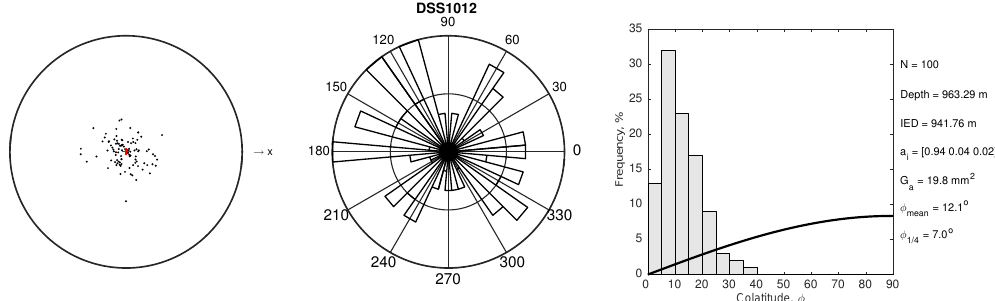
Figure 5. Sample of the thin-section figures included with the data set. From left to right: (i) lower hemisphere c -axis Schmidt plot, (ii) a rose plot of the c -axis azimuth distribution and (iii) a histogram of the c -axis colatitude, φ . The colatitude histograms are annotated with the number of grains, N , in the distribution; the actual ice depth; ice-equivalent depth (IED); eigenvalues, a i , of the orientation tensor (cid:51) ; mean grain area, G a ; mean colatitude, φ mean ; and the cone angle containing the first quartile of c -axis colatitudes, φ 1